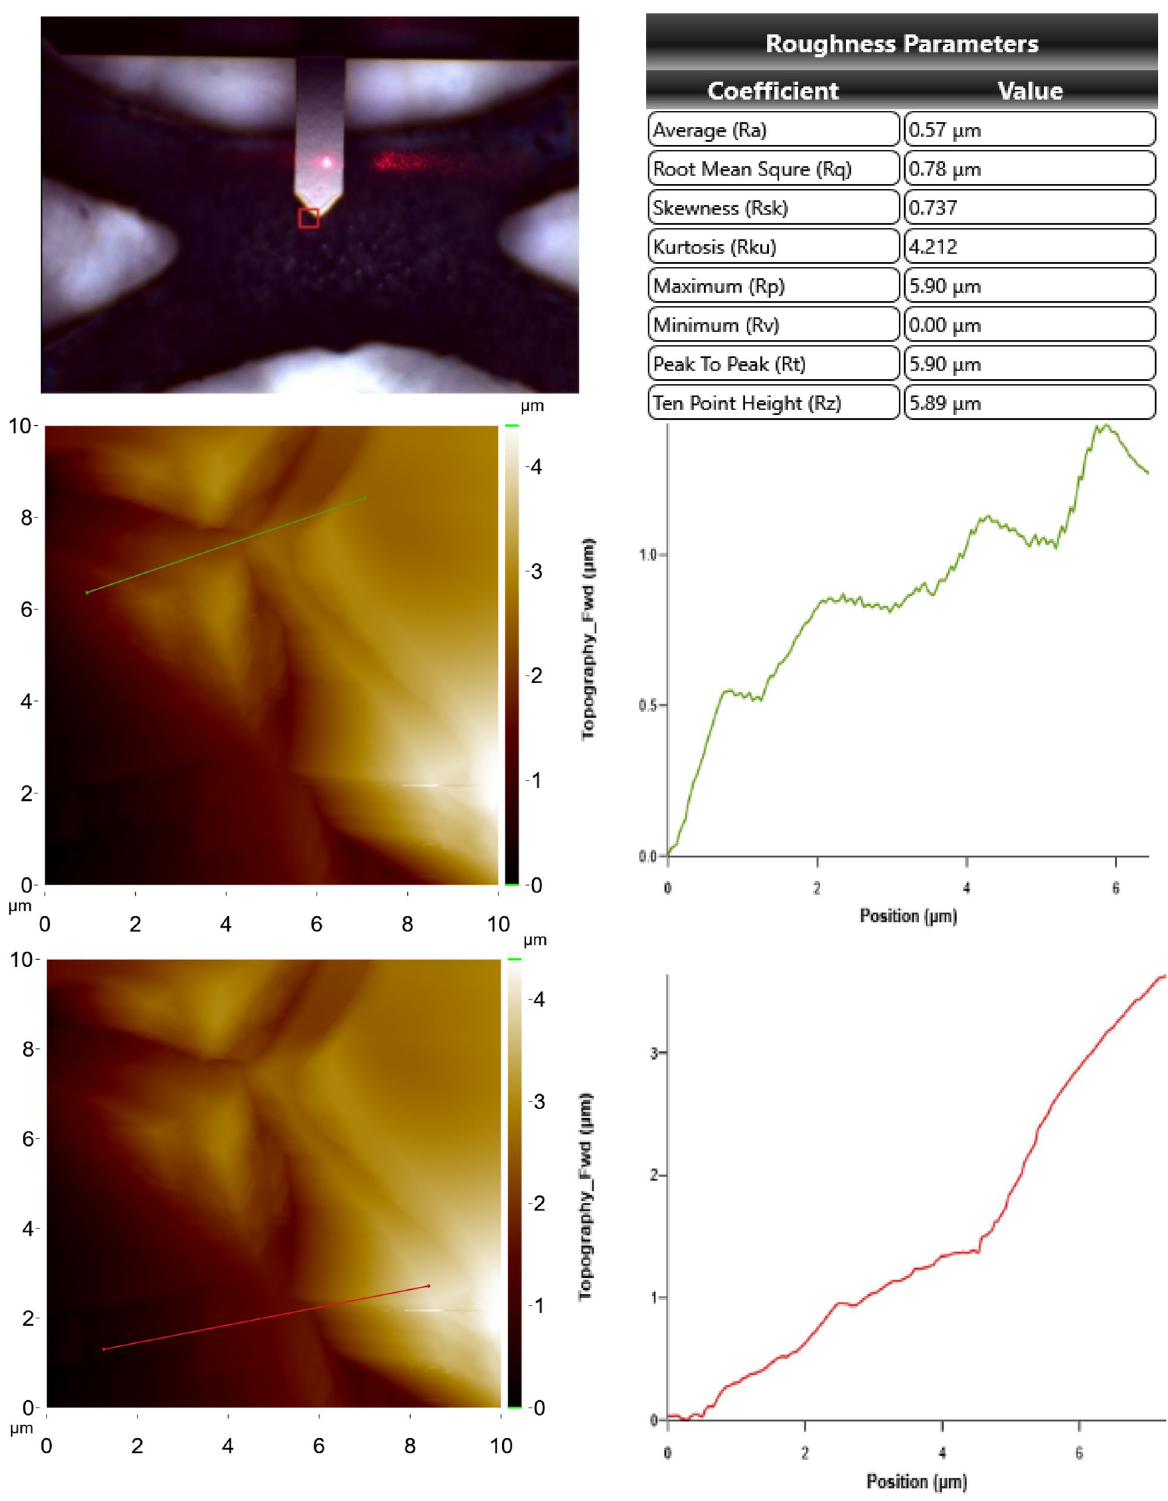
Figure 10. AFM images for upper cross section and bottom cross section of the clean